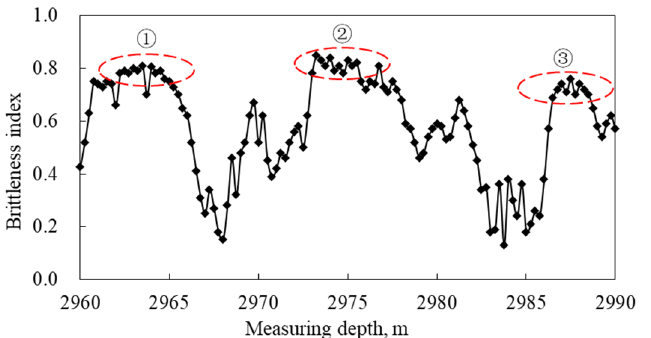
Figure 15. Perforation location optimization results. ① , ② and ③ represent three perforation positions respectively.